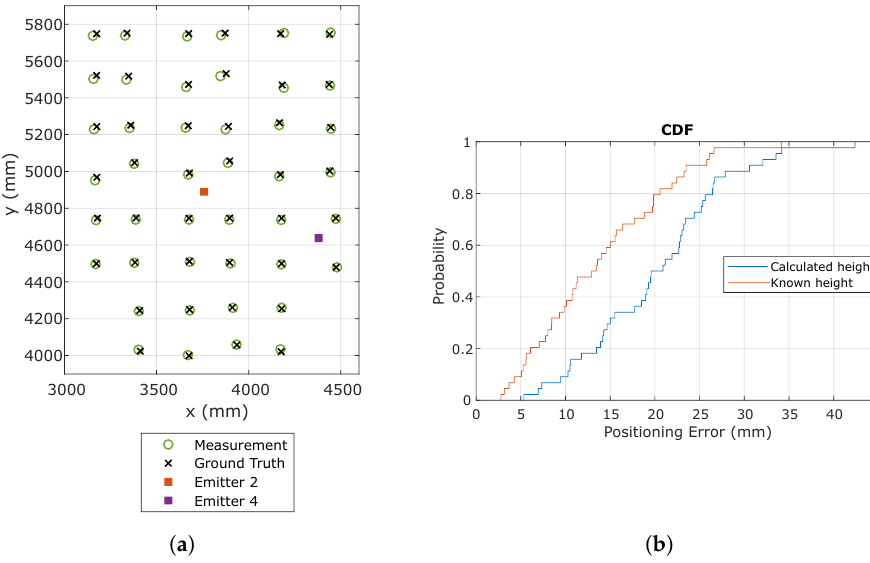
Figure 7. Positioning results using emitters 2 and 4. ( a ) Estimated and true receiver positions using calculated height; ( b ) CDF of the positioning